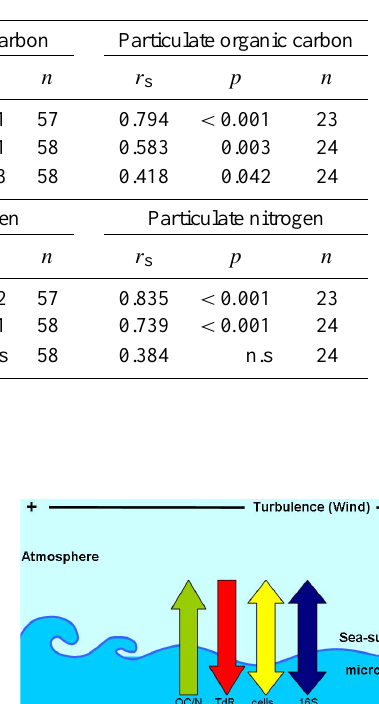
Table 4. Correlations between the enrichment of bacterial parameters and total and particulate matter. Correlations with total organic carbon and total nitrogen are based on SML samples from the southern Baltic Sea taken in 2007 (Stolle et al., 2009) and in May 2008 as well as during the mesocosm experiments. Correlations with particulate organic carbon and particulate nitrogen are based on samples from May 2008 as well as on several mesocosm samples (see Table 3).